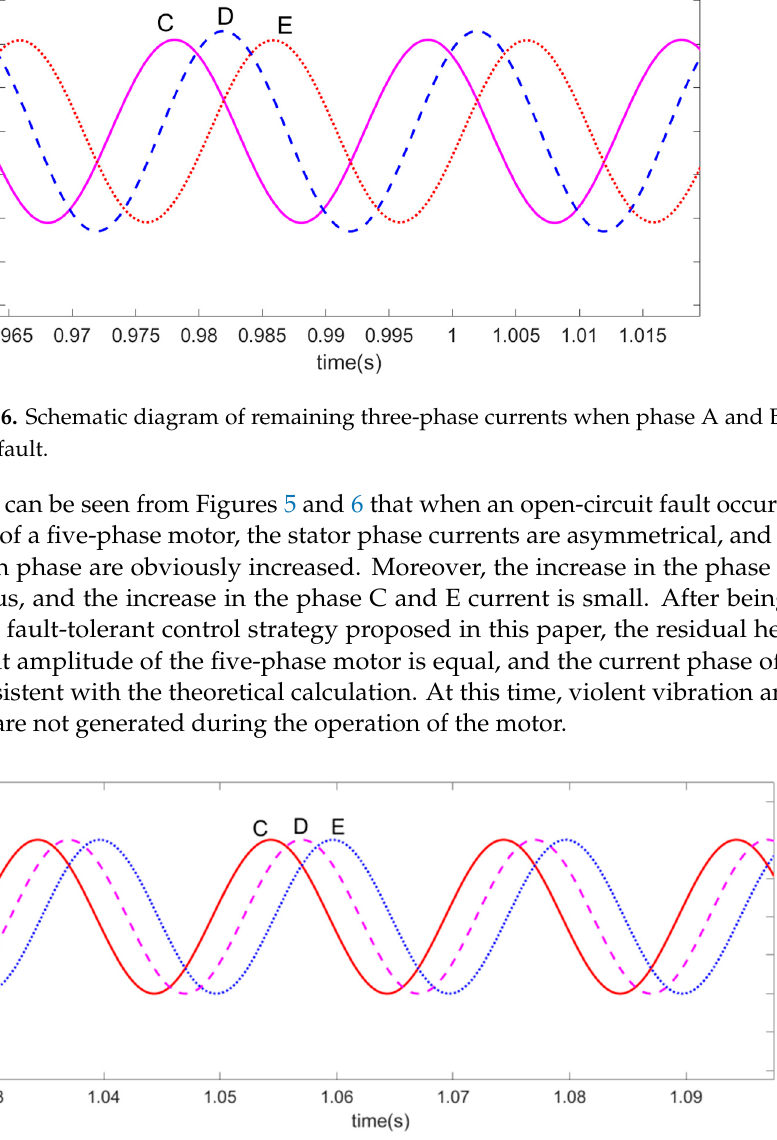
Figure 8. Schematic diagram of remaining three − phase currents when phase A and C are an open − circuit fault. It can be seen from Figures 7 and 8 that when an open − circuit fault occurs in phase A and C of a fi ve − phase motor, the stator phase currents are asymmetrical, and the cur- rents of each phase are obviously increased. Moreover, the increase in the phase D and E current is obvious, and the increase in the phase B current is small. After being con- trolled by the fault − tolerant control strategy, the residual healthy phase current ampli- tude of the fi ve − phase motor is equal, and the current phase of each phase is consistent with the theoretical calculation.